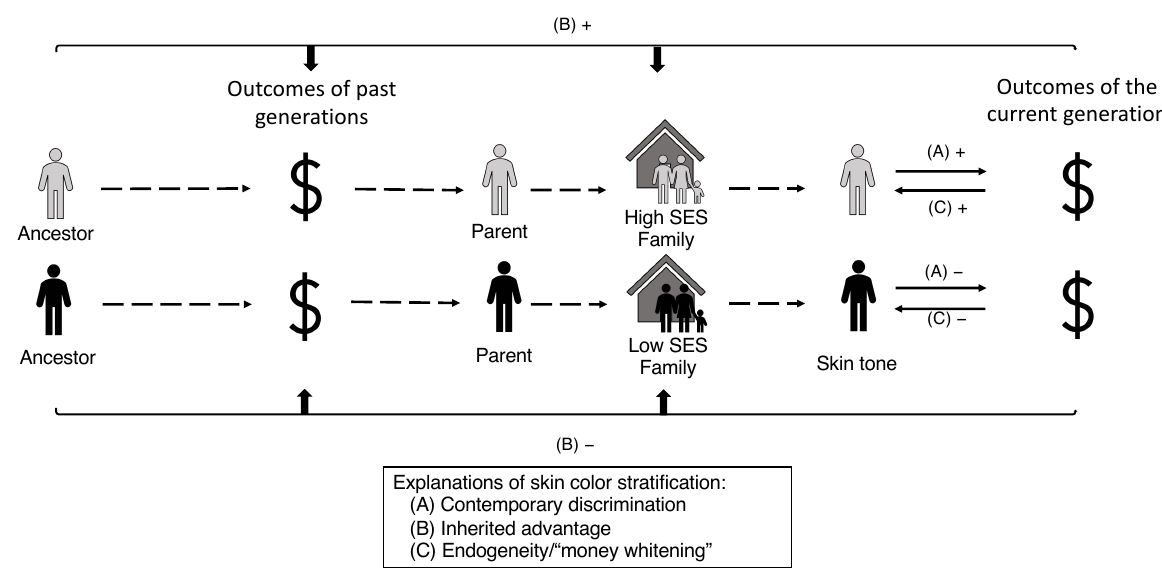
Figure 1: Theoretical pathways linking skin color and (labor market) outcomes. Note: SES stands for socioeco- nomic